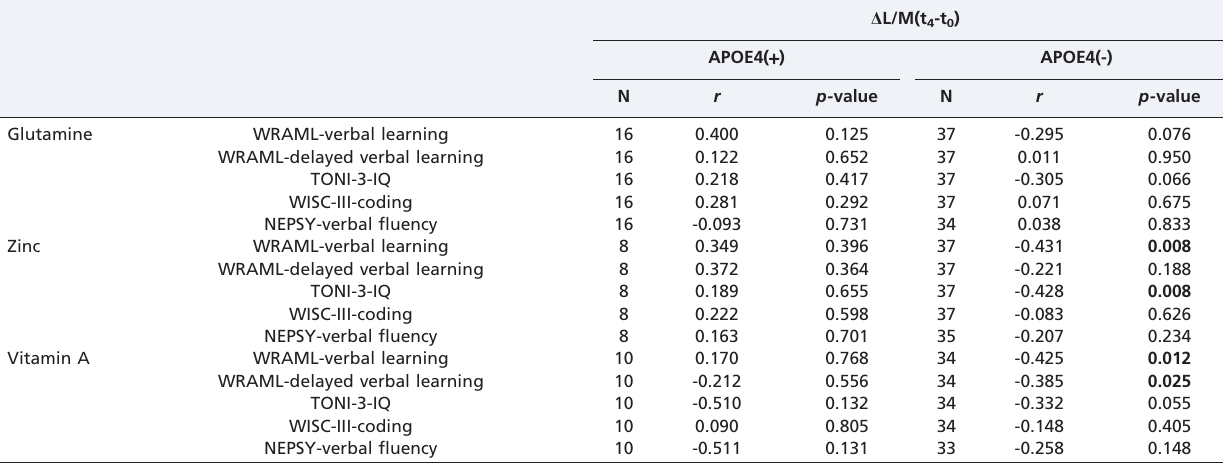
Table 5 - Pearson correlations between the change in the lactulose:mannitol (L/M) ratio (an intestinal permeability indicator) during the initial 4 months of nutritional supplementation and the battery of cognitive tests used to study shantytown children segregated by micronutrient supplementation and APOE4 allele